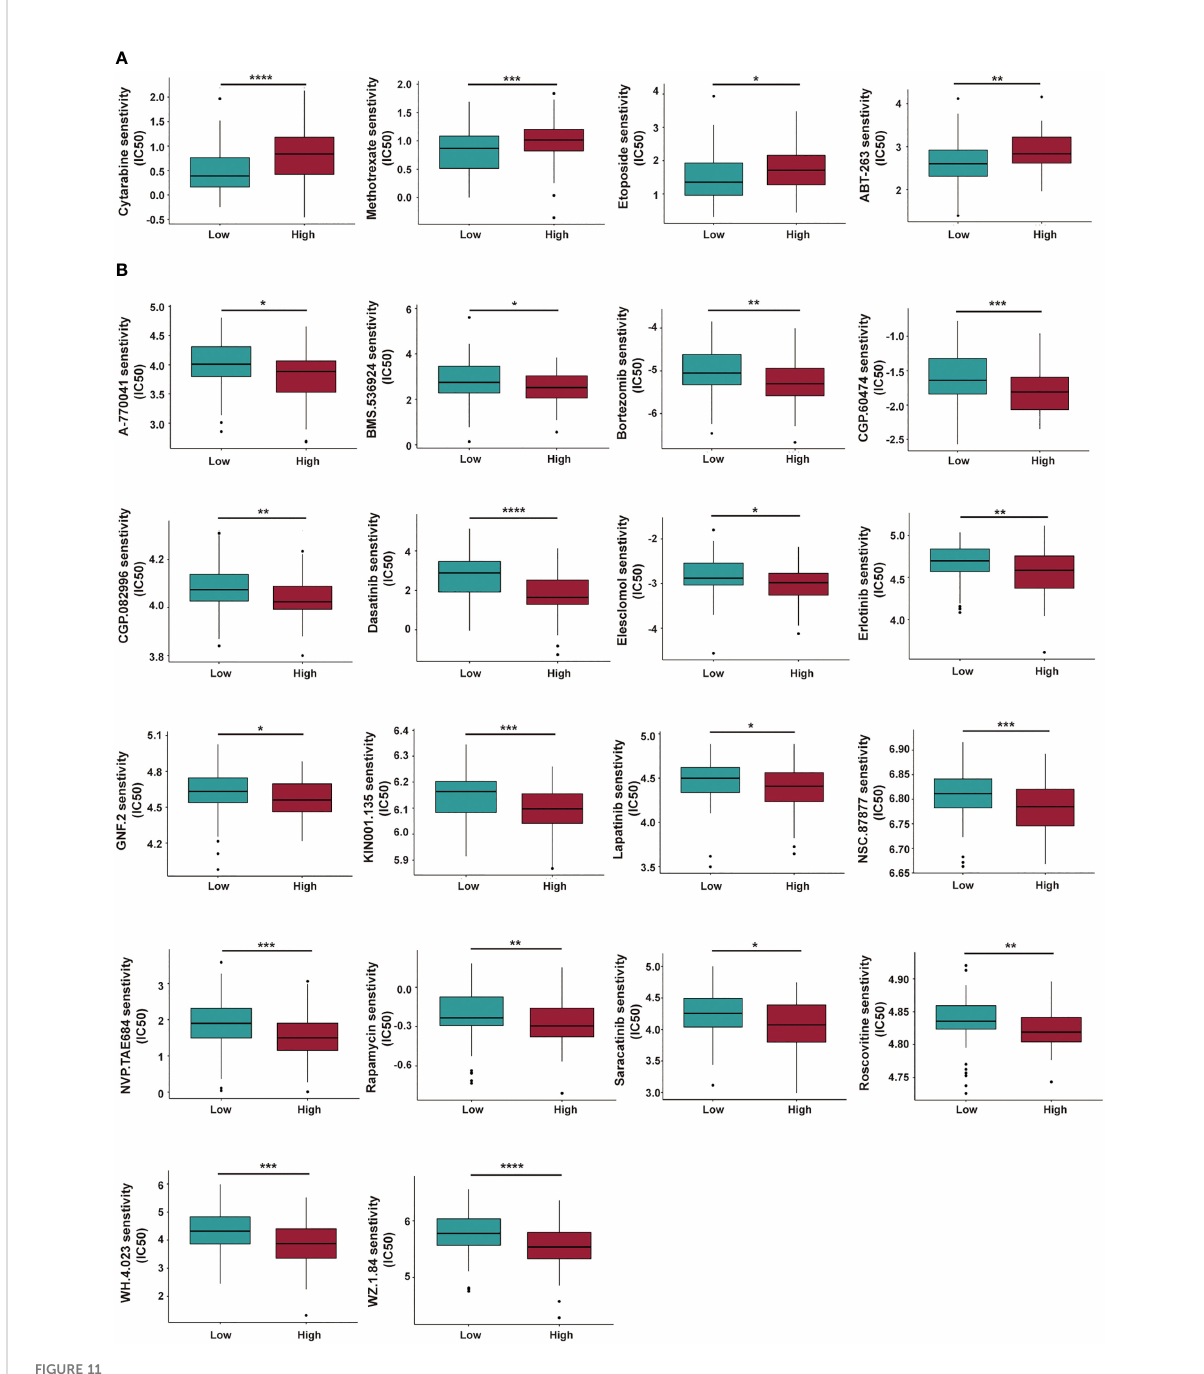
FIGURE 11 Investigation of chemotherapeutic and targeted therapy for AML patients with low- and high-risk groups. (A, B) The high-risk AML patients have a higher IC50 (A) and lower IC50 (B) for multiple potential drugs based on the GDSC database. IC50: Half-maximal Inhibitory Concentration. GDSC, Genomics of Drug Sensitivity in Cancer. * P < 0.05; ** P < 0.01; *** P < 0.005; **** P <